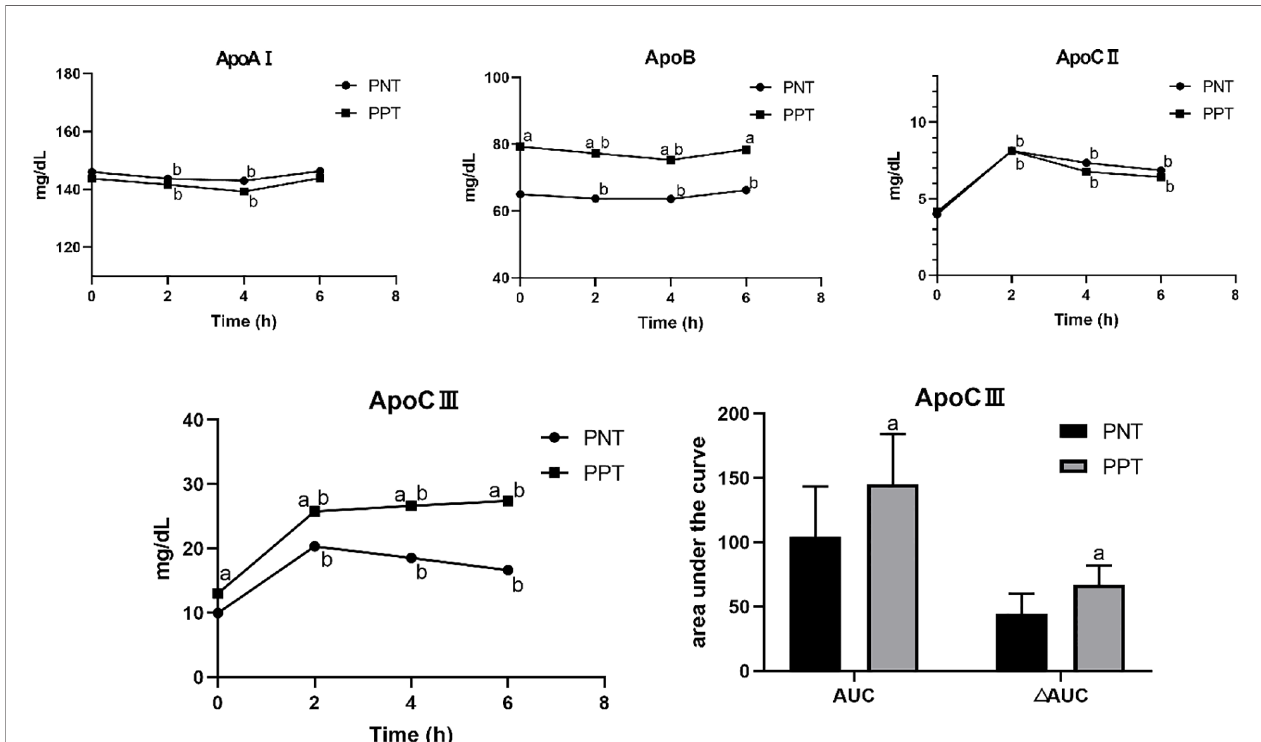
FIGURE 2 | Changes in apolipoprotein levels after a high-fat meal in the two groups PNT, postprandial normal triglyceride; PPT, postprandial hypertriglyceridemia. a P < 0.05, compared with the PNT group; b P < 0.05, compared with the fasting level in the same group.